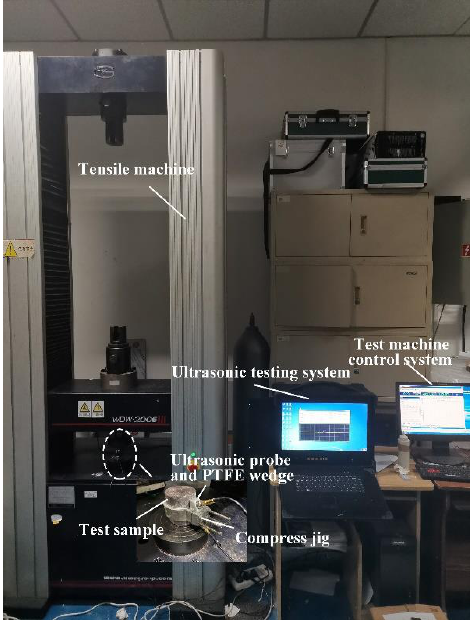
Figure 19. Stress measurement experiment.